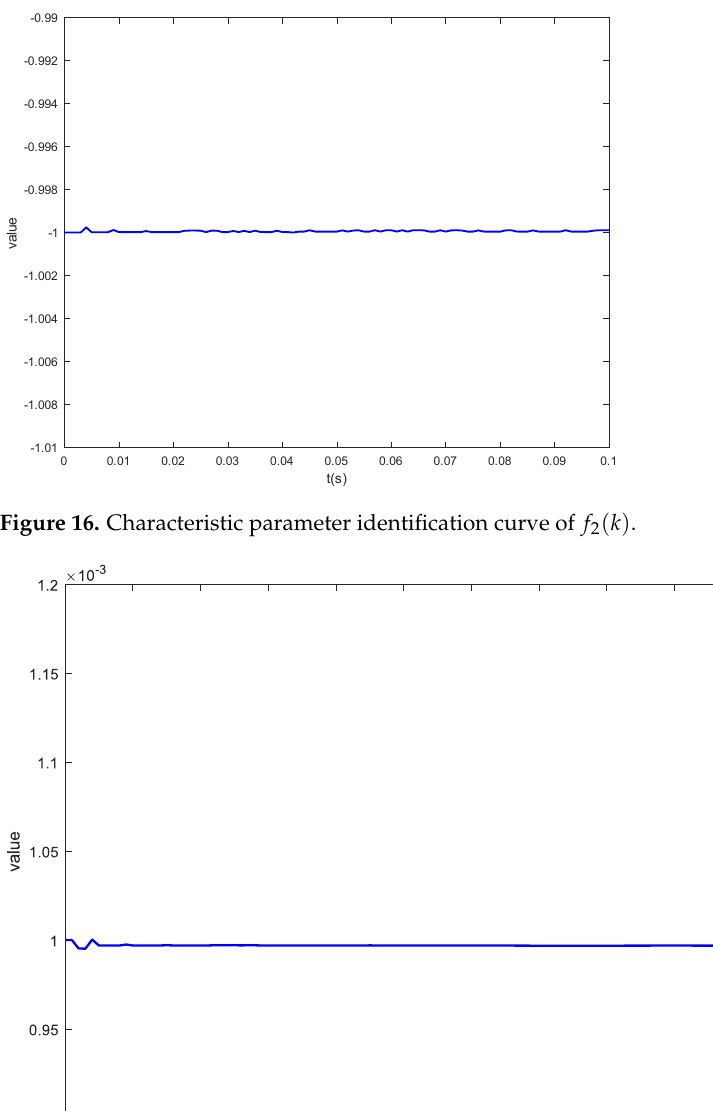
Figure 15. Characteristic parameter identification curve of